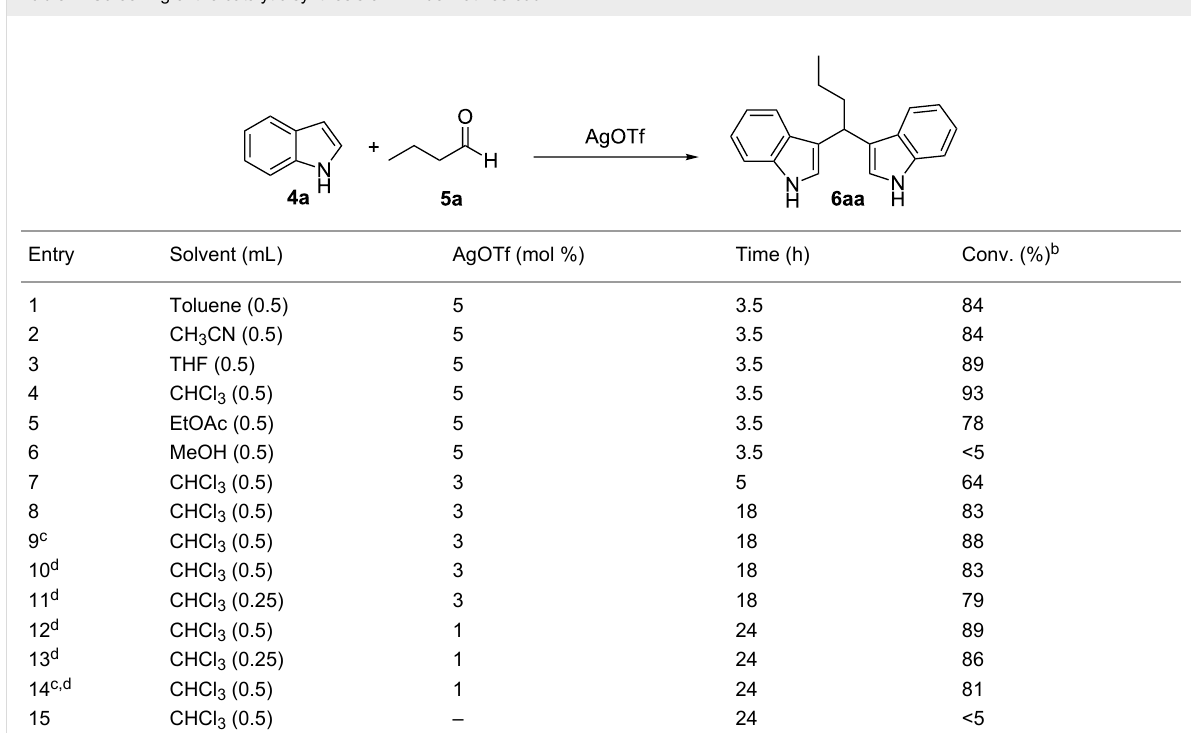
Table 1: Screening of the catalytic synthesis of BIM derivatives 6aa .